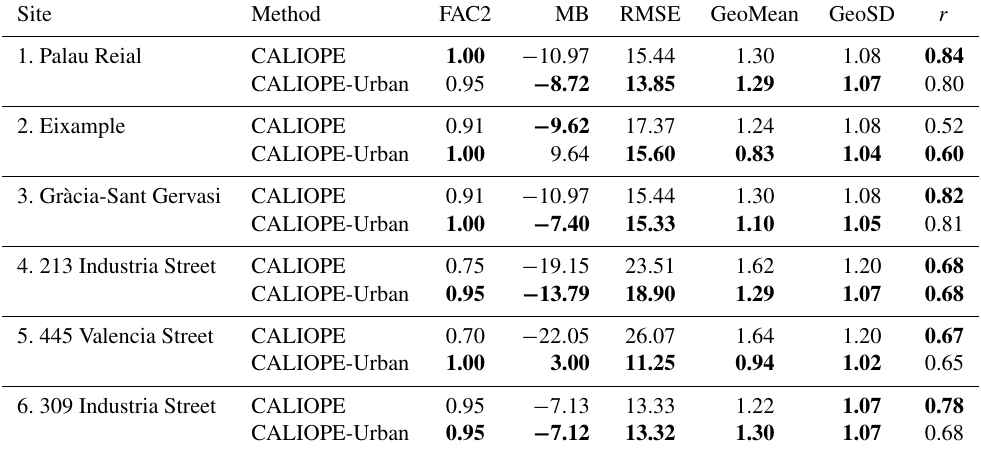
Table B1. NO 2 model evaluation statistics calculated at six sites (described in Sect. 3) during April and May 2013 for CALIOPE and CALIOPE-Urban daily mean concentrations. Bold numbers represent model results with better performance for each statistic and site.